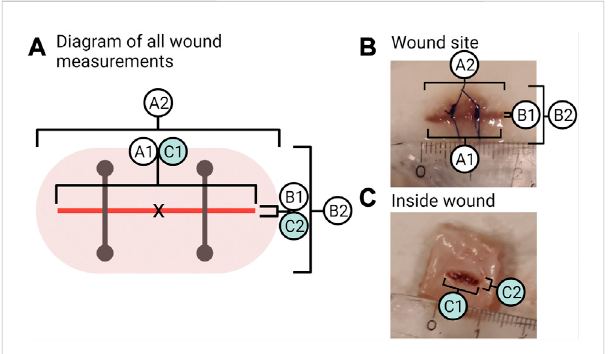
FIGURE 3 Wound measurements. (A) Shows all points measured of the wound where A1 is the length of the incision and B1 is the width of the incision. A2 is the length of in fl ammation, and B2 is the width of in fl ammation. C1 is the inside wound length, and C2 is the inside wound width. (B) Photo of a sample from week 2 in the group “ wound + stress ” showing the measurements of the outside wound for A1, B1, and A2, B2. (C) Photo of a sample from week 2 in the group “ wound + stress ” showing the inside measurements for C1 and